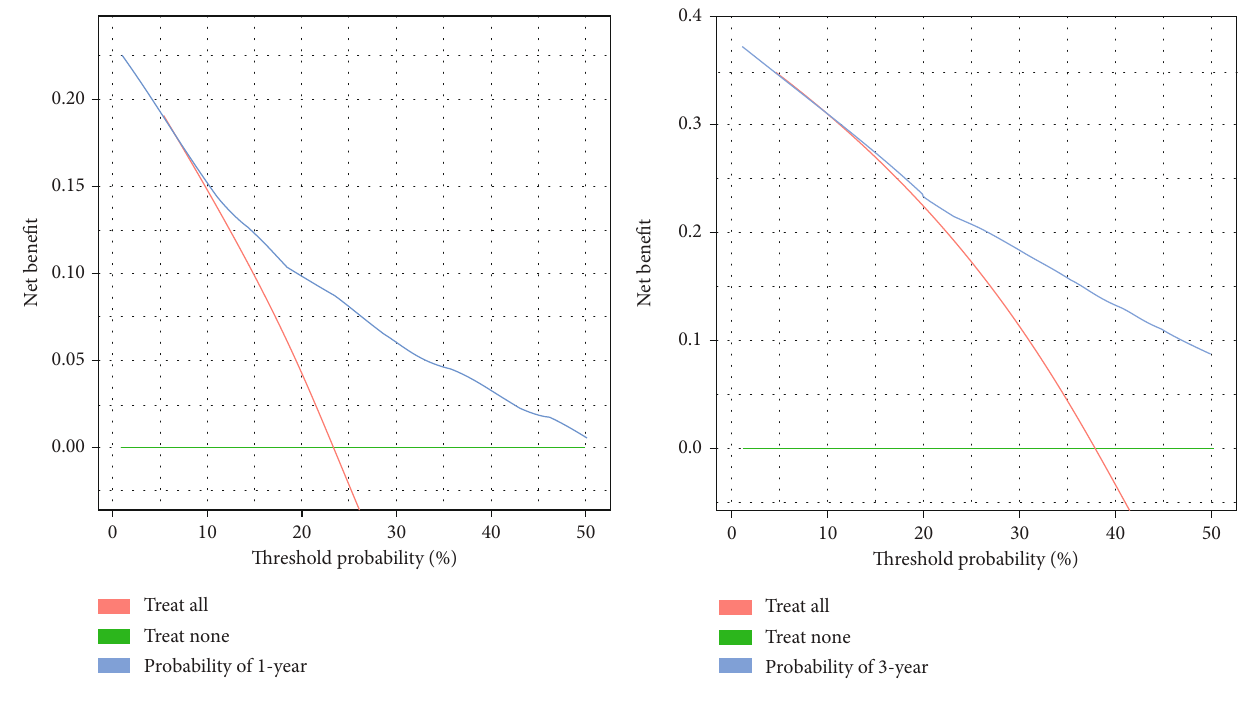
Figure 6: The decision curves in the internal validation cohort.